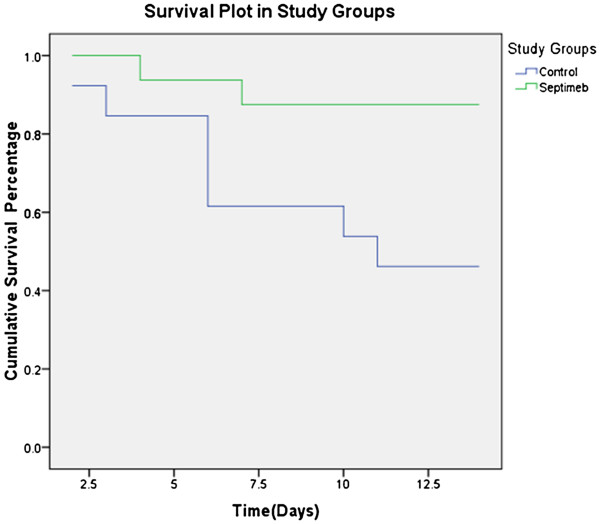
Changes of patient’s survival during study period. The differences in survival time was significant (P=0.019).